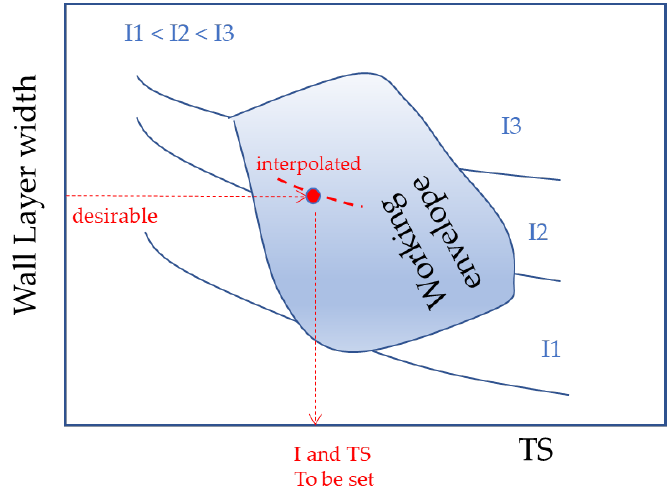
Figure 2. Operational map as a means of selecting parametric sets (current, Im, and travel speed, TS) for a target layer width (LW).